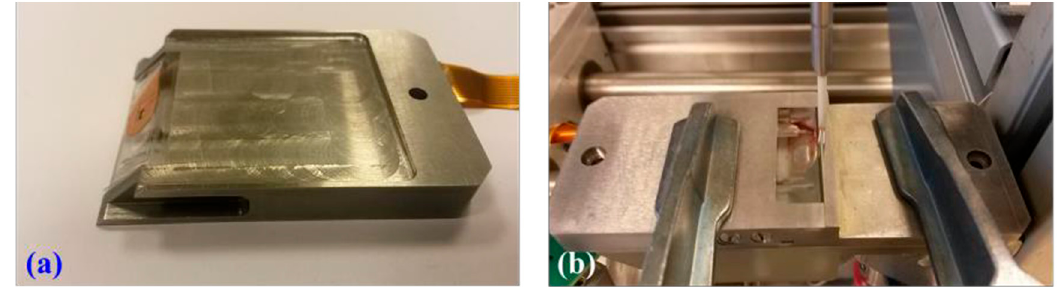
Figure 2. ( a ) Micro-sensor integrated in the actuator hood ( b ) Full assembled actuator with integrated micro-sensor on the testing